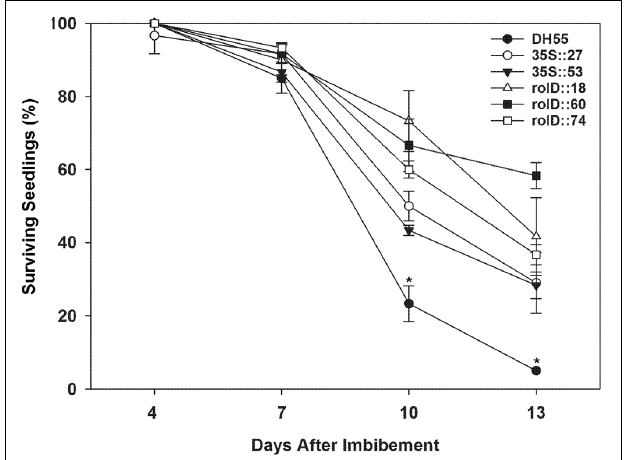
FIGURE 7 | The effect of acdS expression on the seedling survival in the presence of salt (20 dSm − 1 ). Lines tested include wild-type C. sativa DH55 or independent, single insert, homozygous transgenic lines expressing the acdS gene under the control of the root-specific rolD promoter or the constitutive CaMV 35S promoter. Error bars indicate standard error [60 seeds divided in three plates (20 seeds/plate)]. ANOVA and Tukey post-test were used to detect significant differences between groups. Asterisks( ∗ ) indicate control (DH55) values that are significantly different ( p < 0.05) from the transgenic